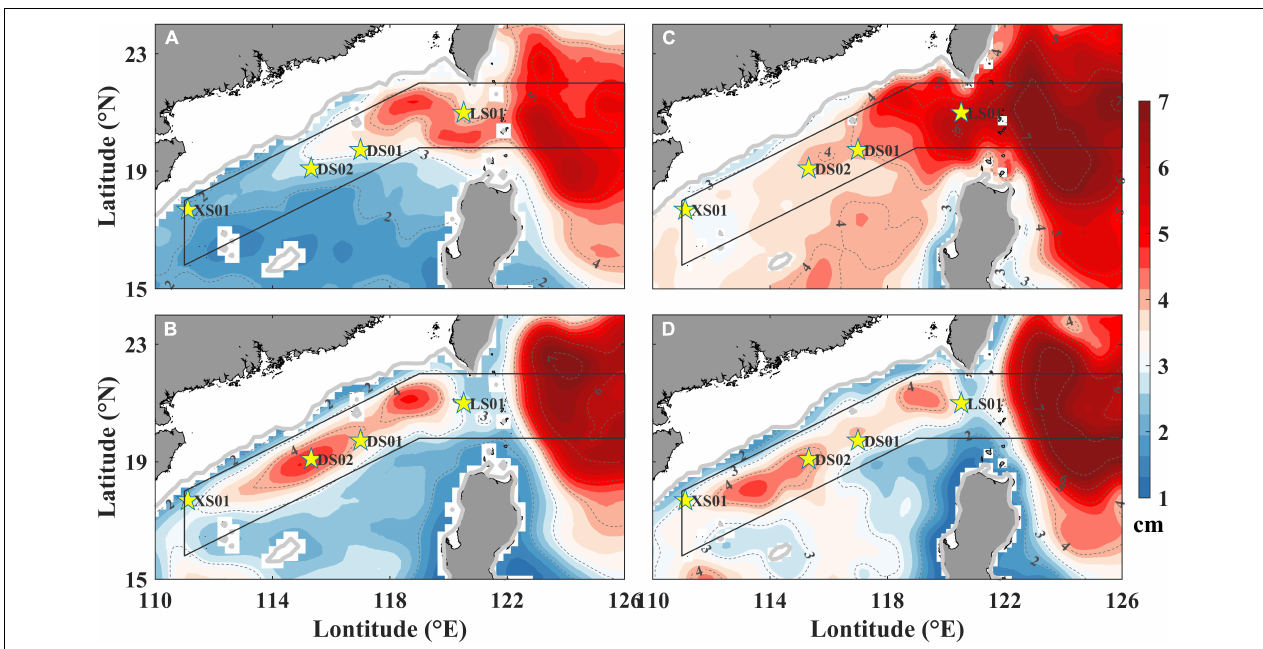
FIGURE 8 | The annual mean standard deviation of intraseasonal sea level anomaly (SLA, cm) and sea surface height (SSH, cm) of the two periods derived from AVISO (HYCOM). (A) 10–65-day SLA; (B) 65–110-day SLA; (C) 10–65-day SSH; (D) 65–110-day SSH. Solid gray line: 200 m isobath; yellow stars: mooring